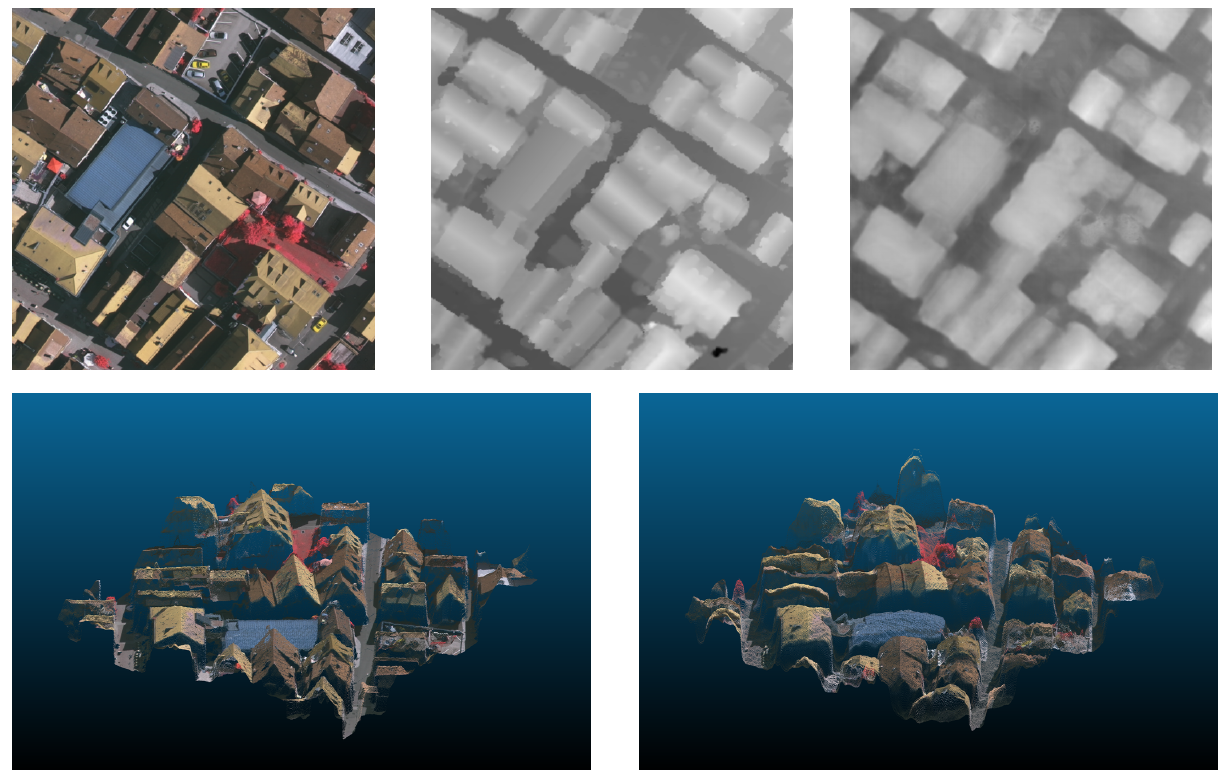
Figure 3. Color information from the image (top left), mapped to a point cloud with x, y (pixel position) and (relative) height from ground truth (top center) and our regression (top right). A screenshot from each pointcloud is shown in the bottom row: ground-truth left and our regression